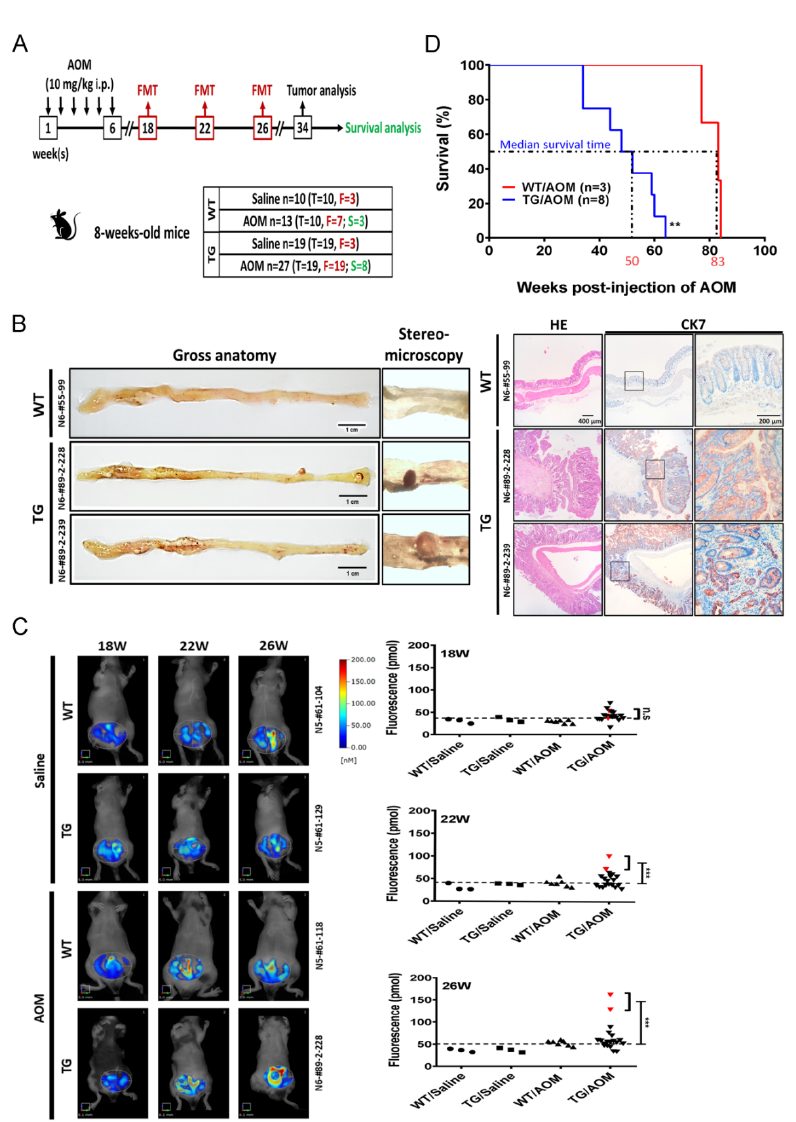
Figure 2. Ectopic TIAM2S expression increases the susceptibility to AOM-induced carcinogenesis. ( A ) Schematic representation of the experimental protocol of the AOM-induced colon cancer model. See Materials and Methods for a detailed description. The boxed number indicates weeks after starting the experiment/treatment. The black and red arrows specify time points for AOM injection and Fluorescence Molecular Tomography (FMT) monitoring, respectively. N: total number of animals used in each group, T: number of animals used for tumor assessment, F: number of animals used for FMT monitor, S: number of animals used for survival analysis. ( B ) Representative colonic images of WT and TG mice under AOM treatment. Examinations of gross anatomy and under stereomicroscopy (left), as well as H&E stain and IHC staining with CK7 are shown. Scale bar: 1 cm. ( C ). In vivo fluorescent tomographic imaging of mice under different treatments. Representative colonic field of chromatogram showed each experimental condition at the 18th, 22nd, and 26th weeks (left). Quantifications of fluorescent tomographic signals from animals under different treatments were plotted (right). Dot plots of three time points displaying the distribution of each animal’s signal. Red inverted triangle indicates two animals with tumor. The averaged signals from animals with tumor were compared to that from the normal animals at three time points. ( D ) The Kaplan–Meier survival curve was plotted and estimated median survival times of TIAM2S-TG (50 weeks) and WT (83 weeks) animals were compared. For all statistics, NS: not significant, ** p < 0.01, *** p <